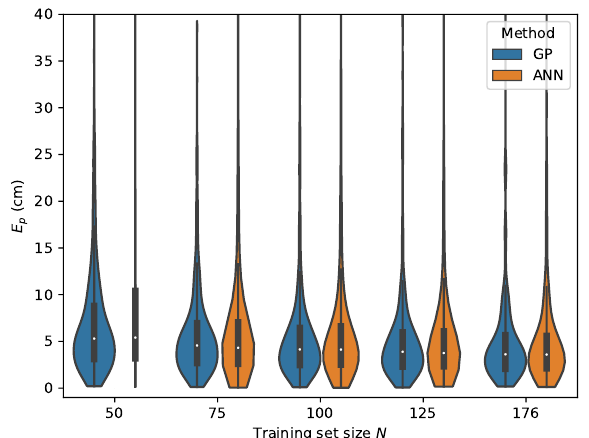
Figure 16. Cross-validation with set B where the r rel , max input features are used.